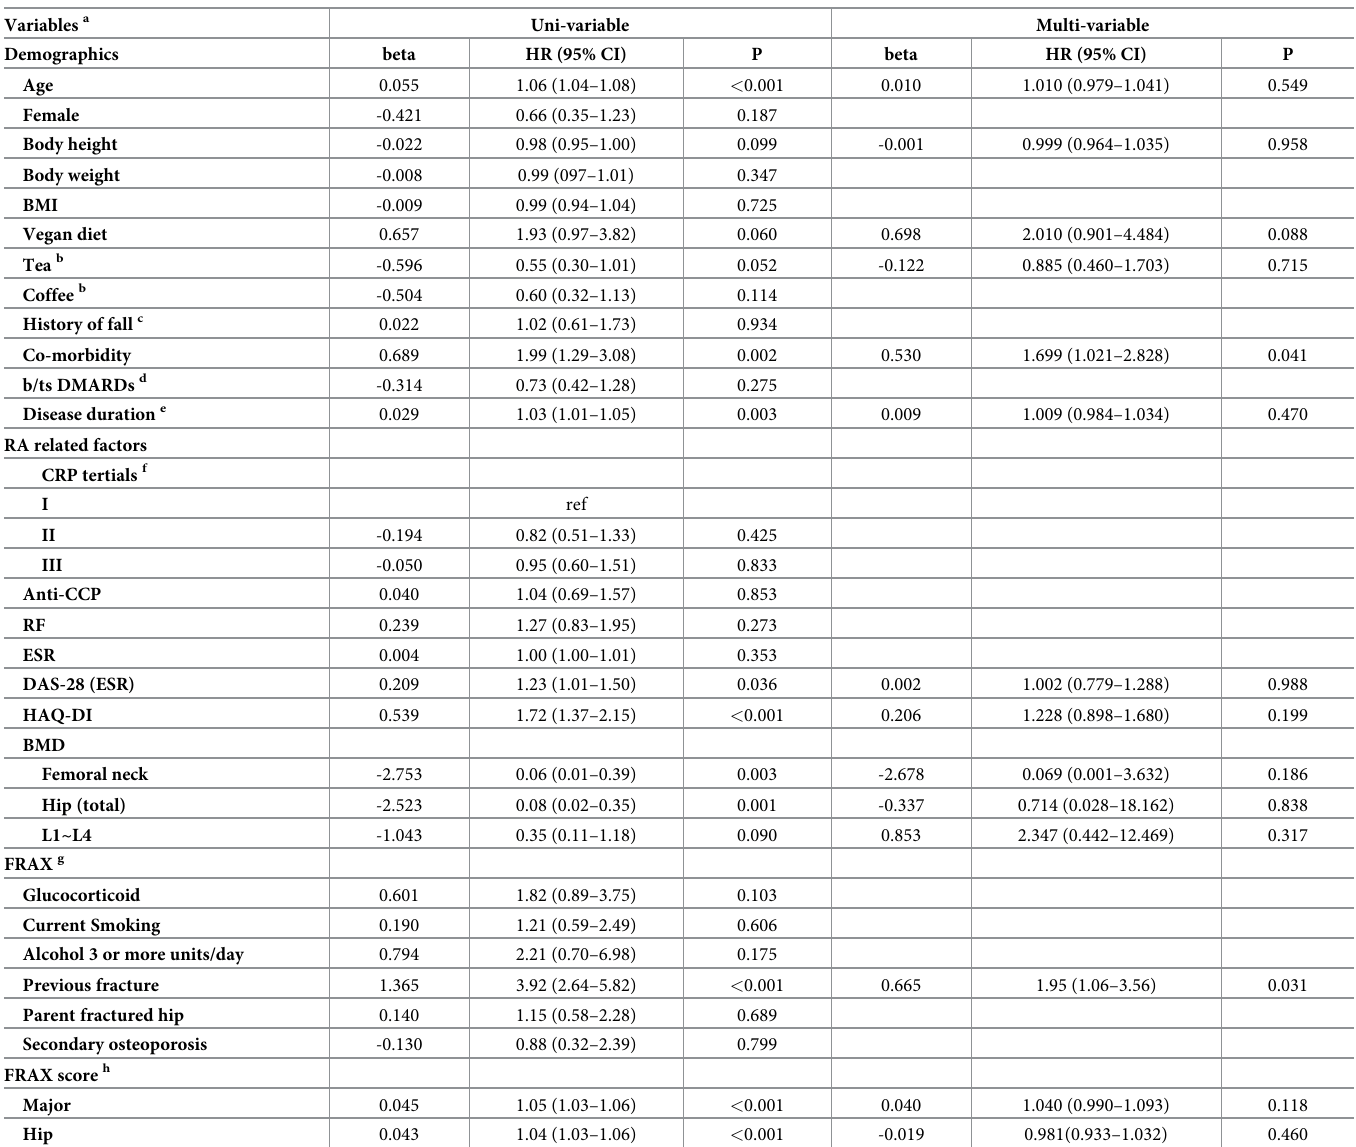
Table 2. Risk factor analysis of new incident fracture before